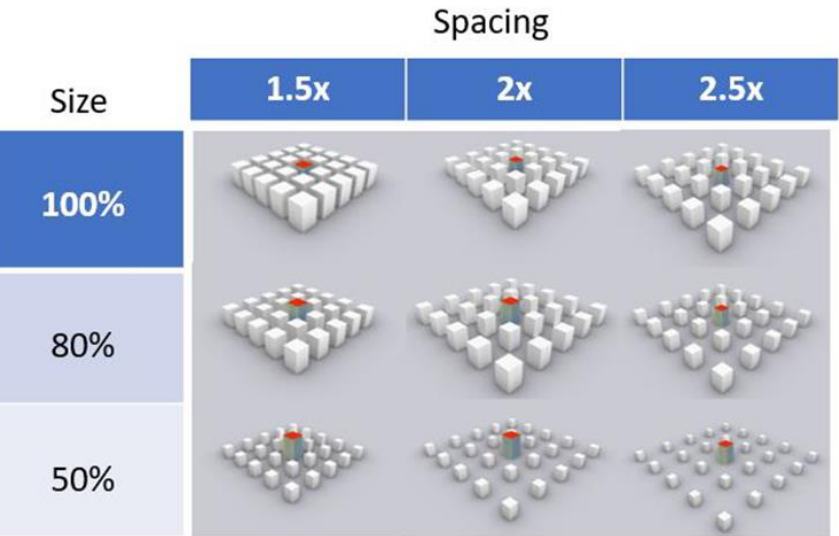
Figure 2. Nine conceptual urban settings were modeled varying the size and proximity of the surrounding rectangular buildings.